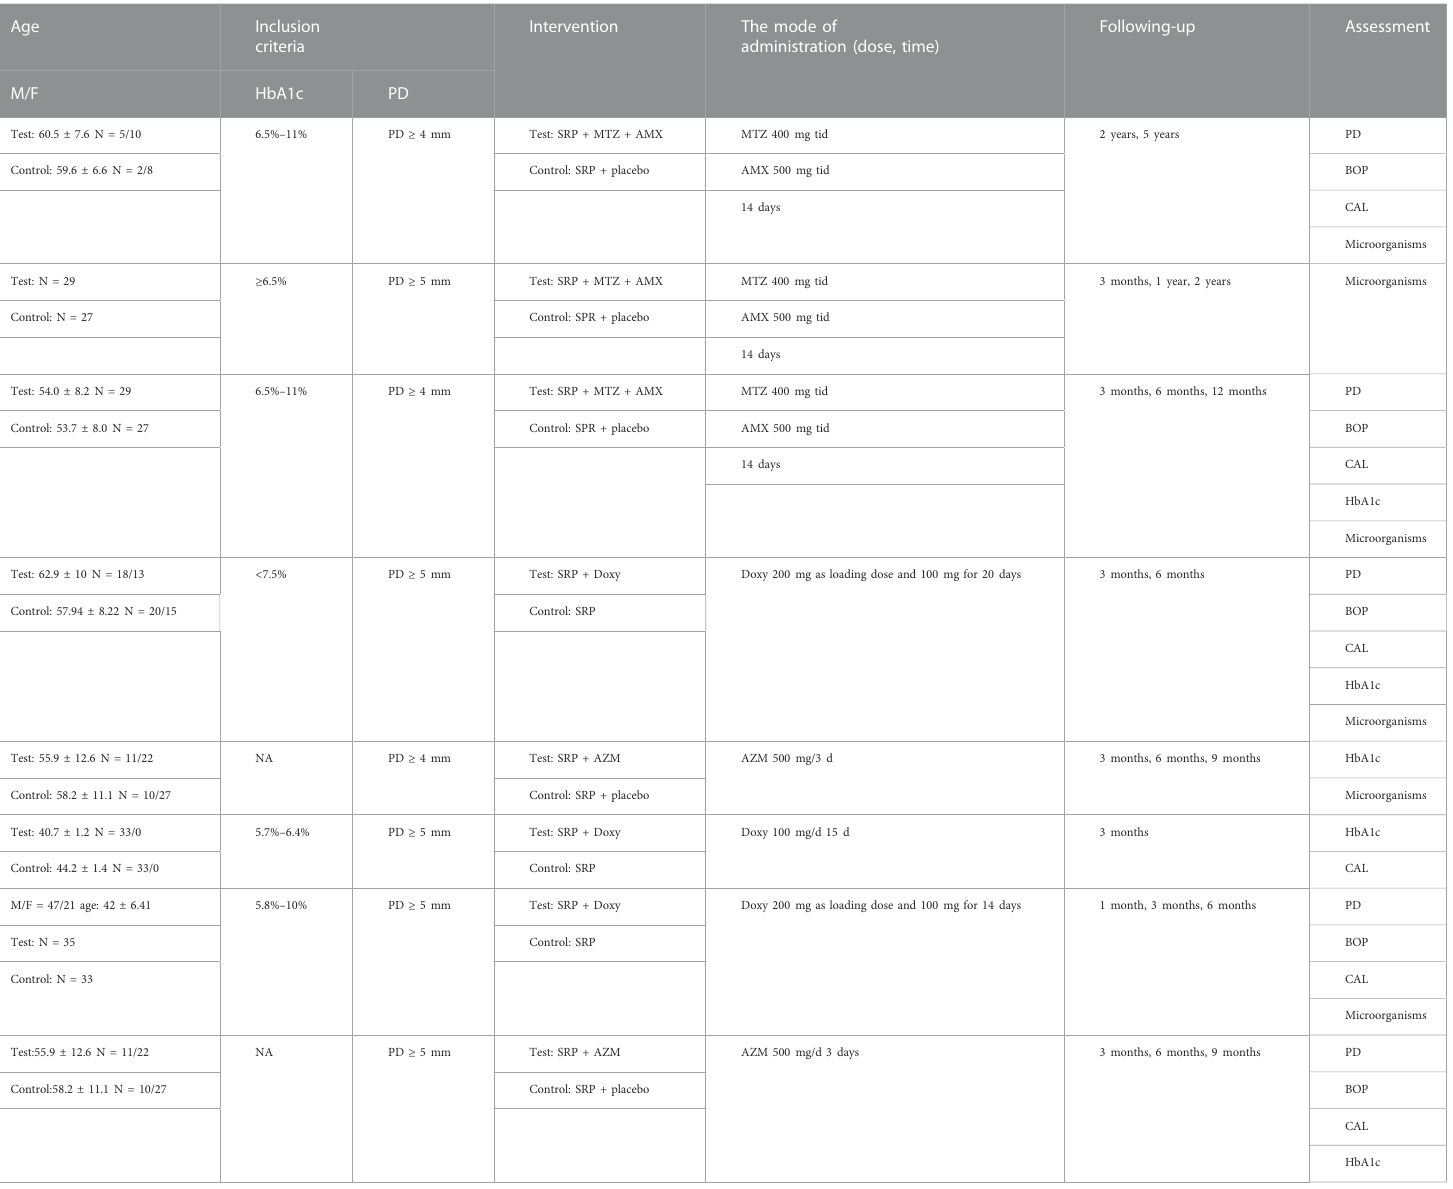
TABLE 1 General information provided in the included studies —— systemic